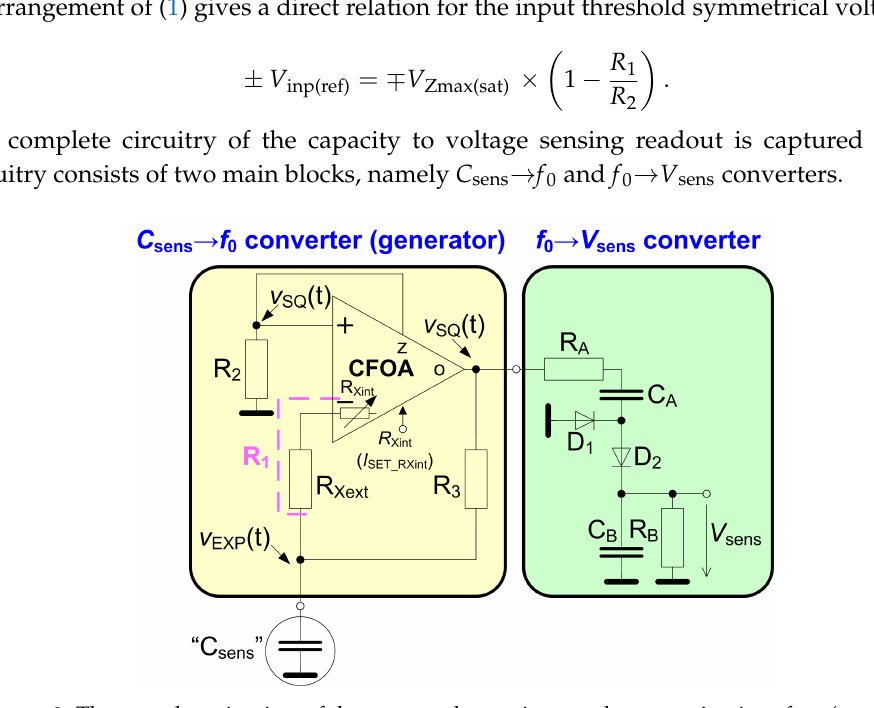
Figure 3. The complete circuitry of the proposed capacity to voltage sensing interface